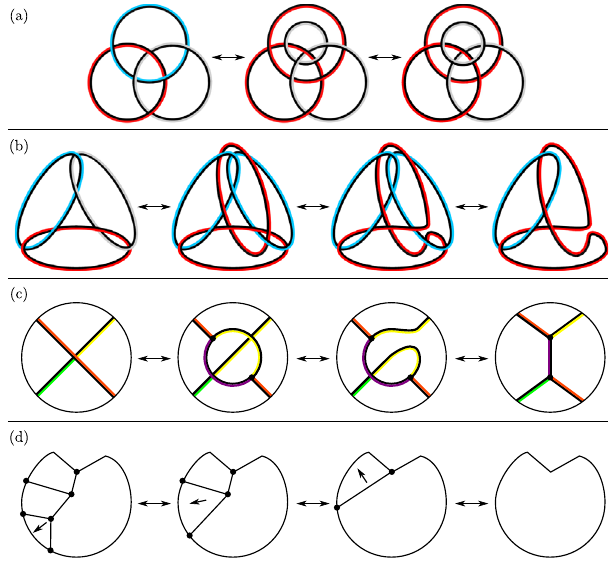
Fig. 5 Decay of colored links via local and global vortex splitting. Any Q 8 - colored link may be unlinked using topologically allowed reconnections, strand crossings and vortex splittings. a Decay of the Q 8 -colored Borromean ring con fi guration, corresponding to Q = [2]. b Decay of the Q 8 - colored looped chain of length three, corresponding to Q = [3]. Defects with Q = [1] can be unlinked in a similar fashion. c Any crossing of a colored link diagram can be eliminated by local vortex splittings and reconnections, which turns the link into a planar vortex network. The bicolorings represent elements of a general group G . A desired factor can always be split off of a vortex, since groups are closed under taking inverses and products. d Arbitrary planar vortex network is transformed into a simple loop by local vortex amalgamations. Hence, there exists no topological vortex links that are topologically protected against decaying via vortex splittings along a signi fi cant distance, in addition to topologically allowed strand crossings and local